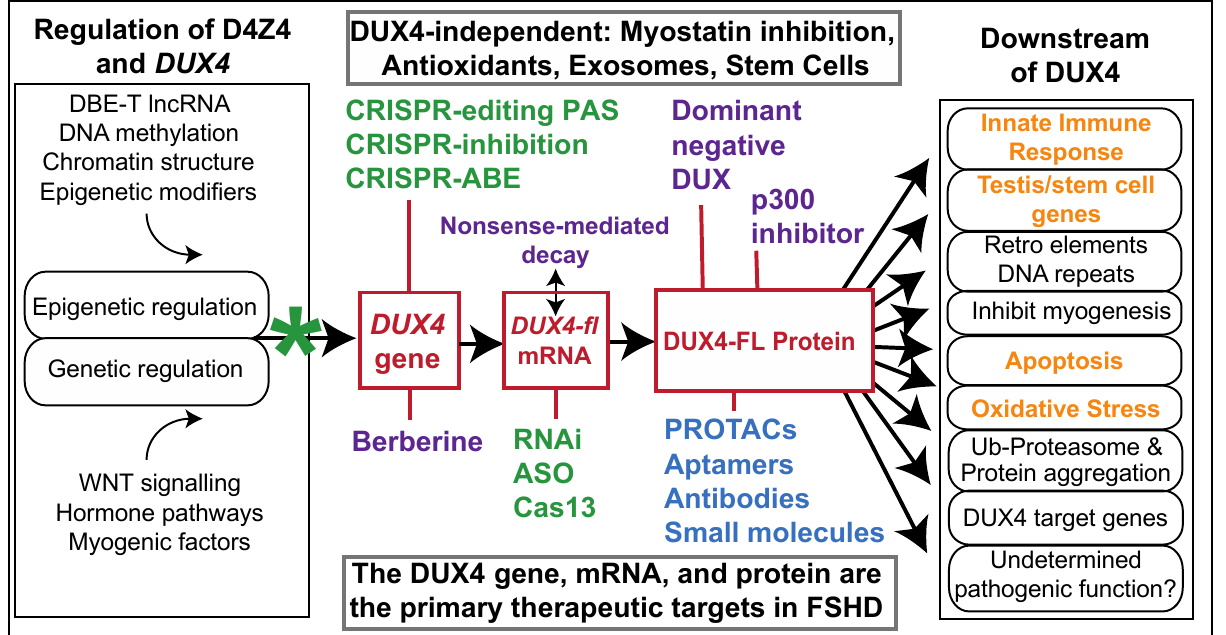
Figure 1. Incomplete silencing of the FSHD locus leads to misexpression of the pathogenic DUX4-fl transcript in skeletal muscles. DUX4-FL subsequently activates a program of embryonic gene expression, which triggers many aberrant downstream events. While some pathways downstream of DUX4 are amenable to targeting (orange), it is not clear which individual pathway, if any, is causal for pathology. Thus, serious efforts to develop specific FSHD therapeutics (green) have focused on restoring silencing to the locus or preventing expression of DUX4-fl mRNA or protein. Purple indicates DUX4-targeting strategies that are inherently promiscuous; asterisk indicates small molecules targeting DUX4 epigenetic regulation or transcription. Blocking DUX4-FL activity (blue) is a theoretically viable avenue, although still in the very early stages of development.